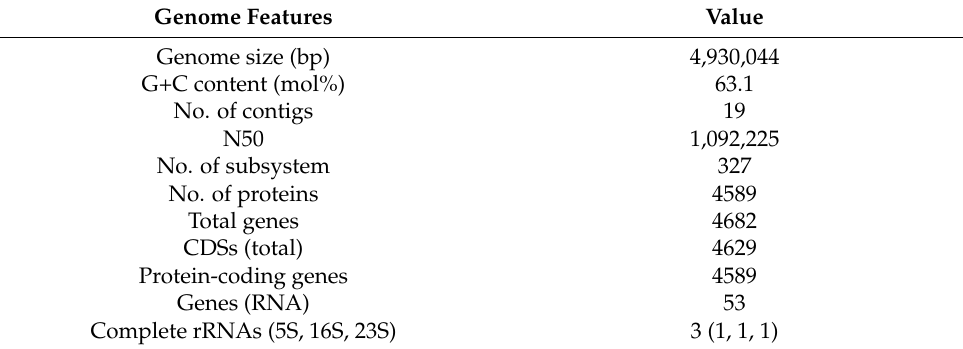
Figure 1. Maximum-likelihood phylogenetic tree based on 16S rRNA gene sequences of strain S-51 T among closely related representatives of the family Rhizobiaceae with previously uncultured bacterium clones. Filled circles indicate nodes recovered by different tree-making algorithms (neighbor–joining and maximum–likelihood). The numbers at the nodes indicate the percentage of 1000 bootstrap replicates yielding this topology; only values >50% are shown. Rhodobacter capsulatus ATCC 11166 T was used as an out-group. GenBank accession numbers are given in parentheses. Bar, 0.02 substitutions/nucleotide position. Table 1. Genome features of strain S-51 T